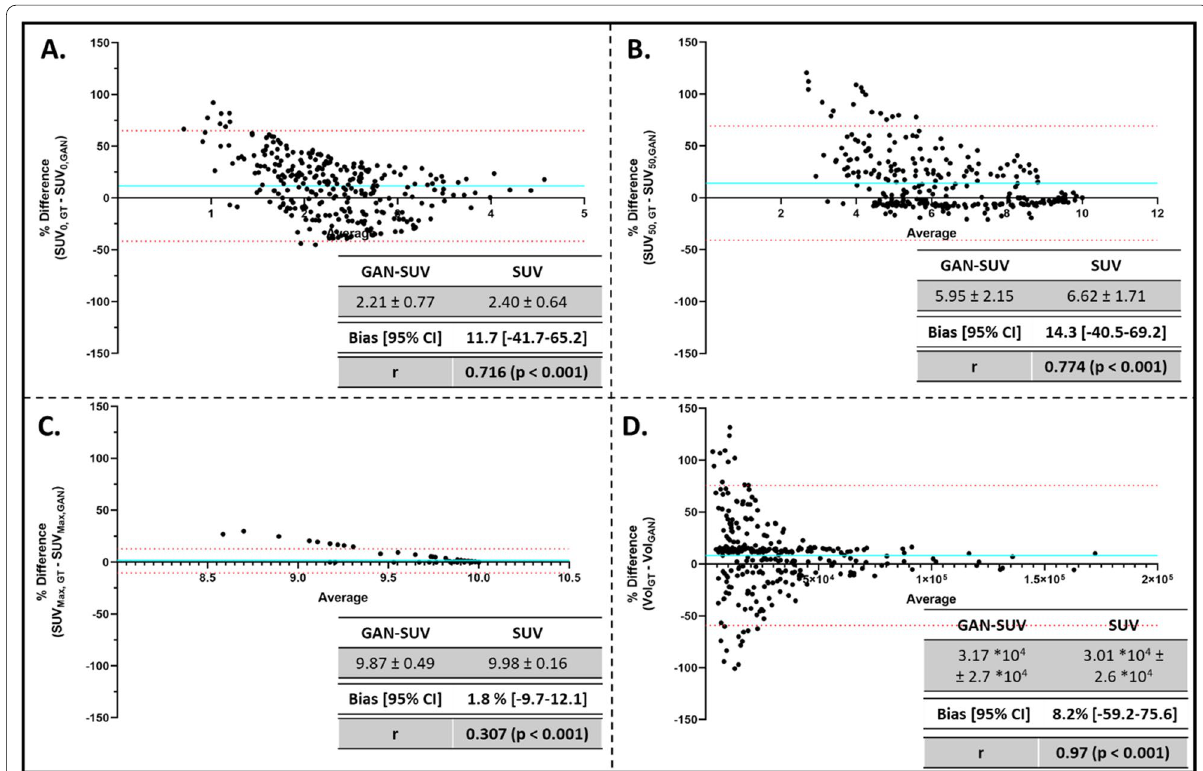
Fig. 4 Technical Assessment of Simulated SUV Map Accuracy. Bland–Altman plots for the SUV 0 ( a ), SUV 50 ( b ), SUV Max ( c ) and tumour volume ( d ) were constructed to assess the percentage difference between the gold standard and generated SUV maps. The bias along with the 95% confidence intervals is indicated in each plot. These assessment criteria were adapted from the PERCIST v.1 criteria to characterise and monitor tumour progression using PET/SUV